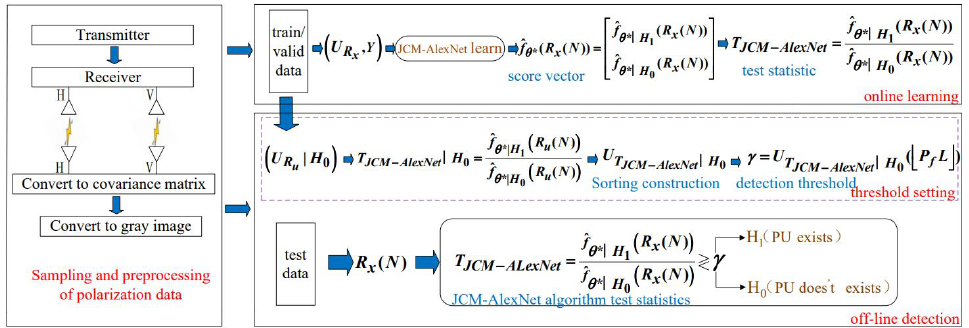
Figure 1. JCM-AlexNet spectrum sensing algorithm